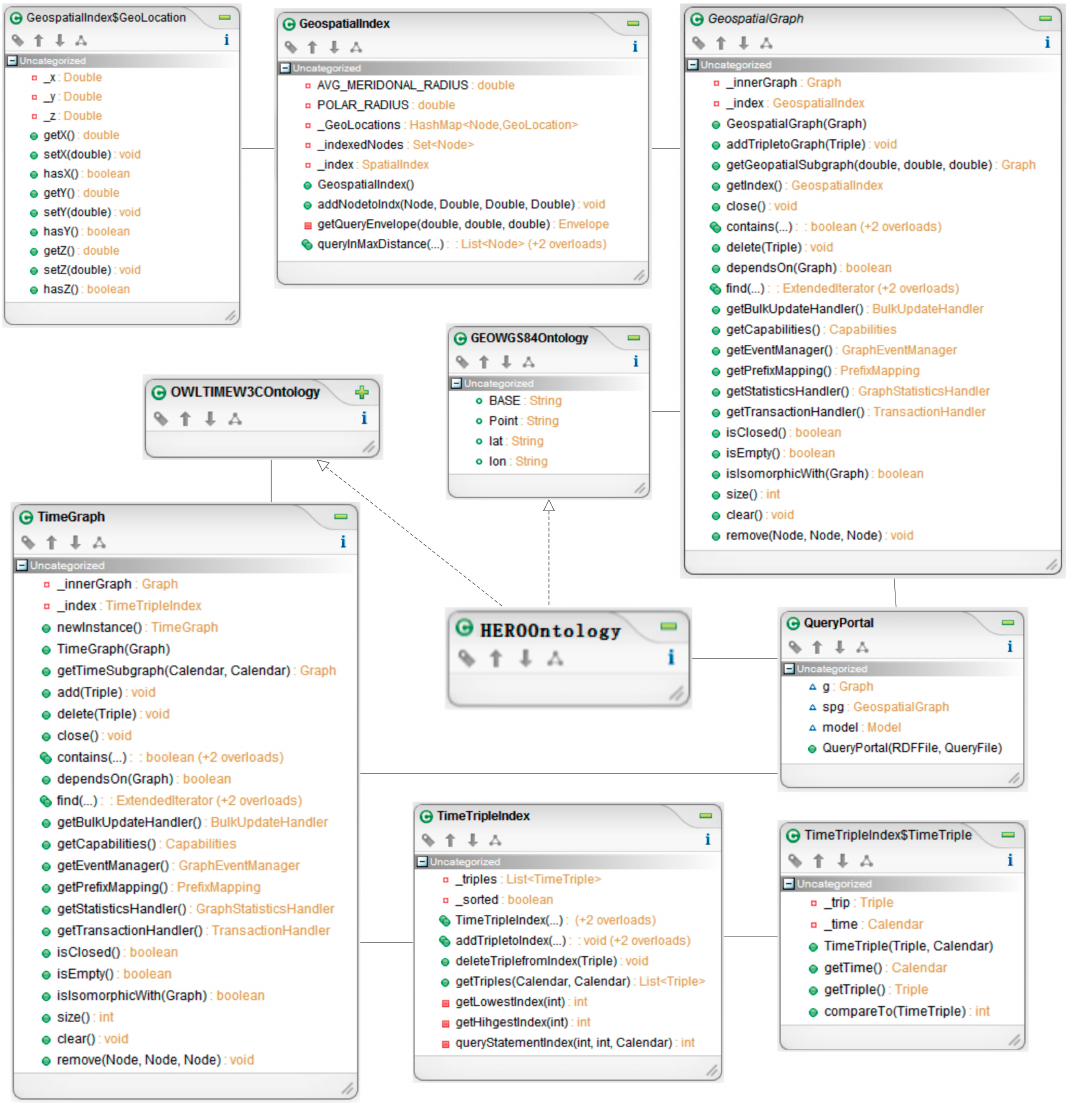
Figure 8. Spatiotemporal Query Agent Class Diagram.